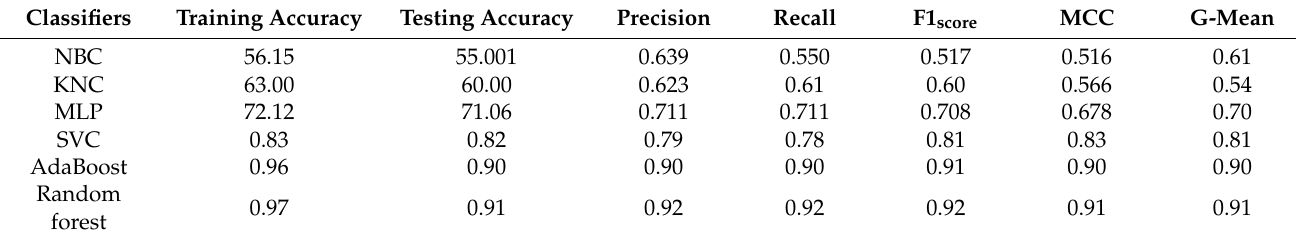
Table 5. The performance of machine learning classifiers for drill bit selection in the first